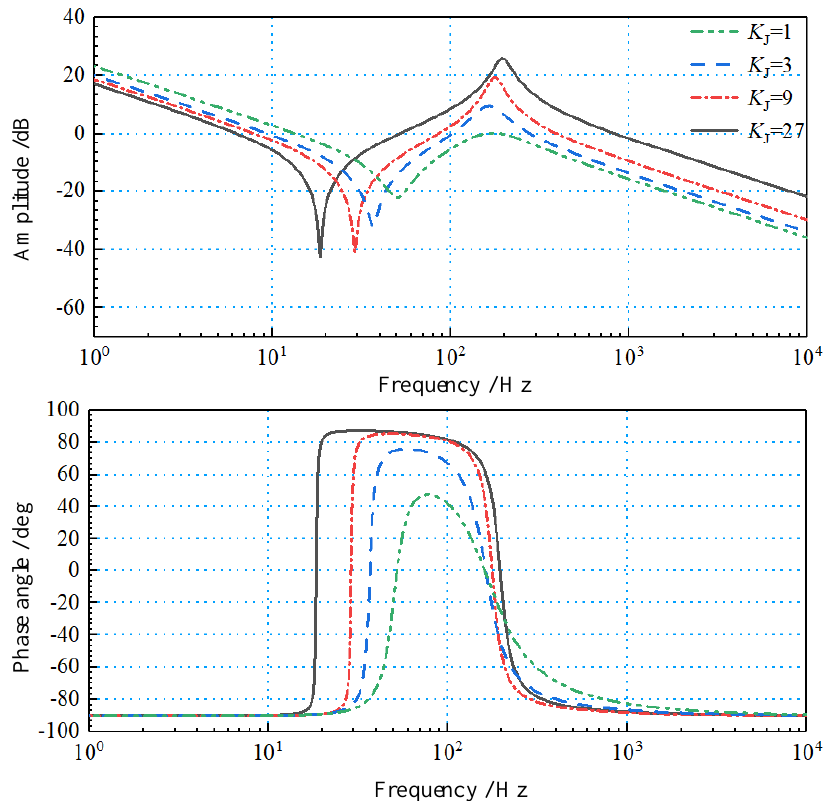
Figure 15. Open-loop Bode diagram under different moment of inertia ratios.